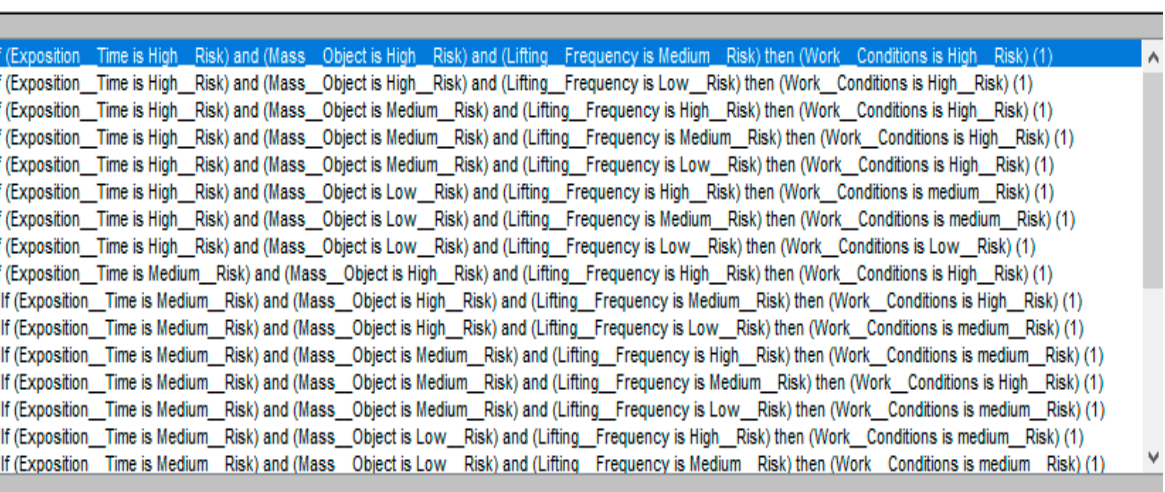
Figure 8. Fuzzy rules of decision.